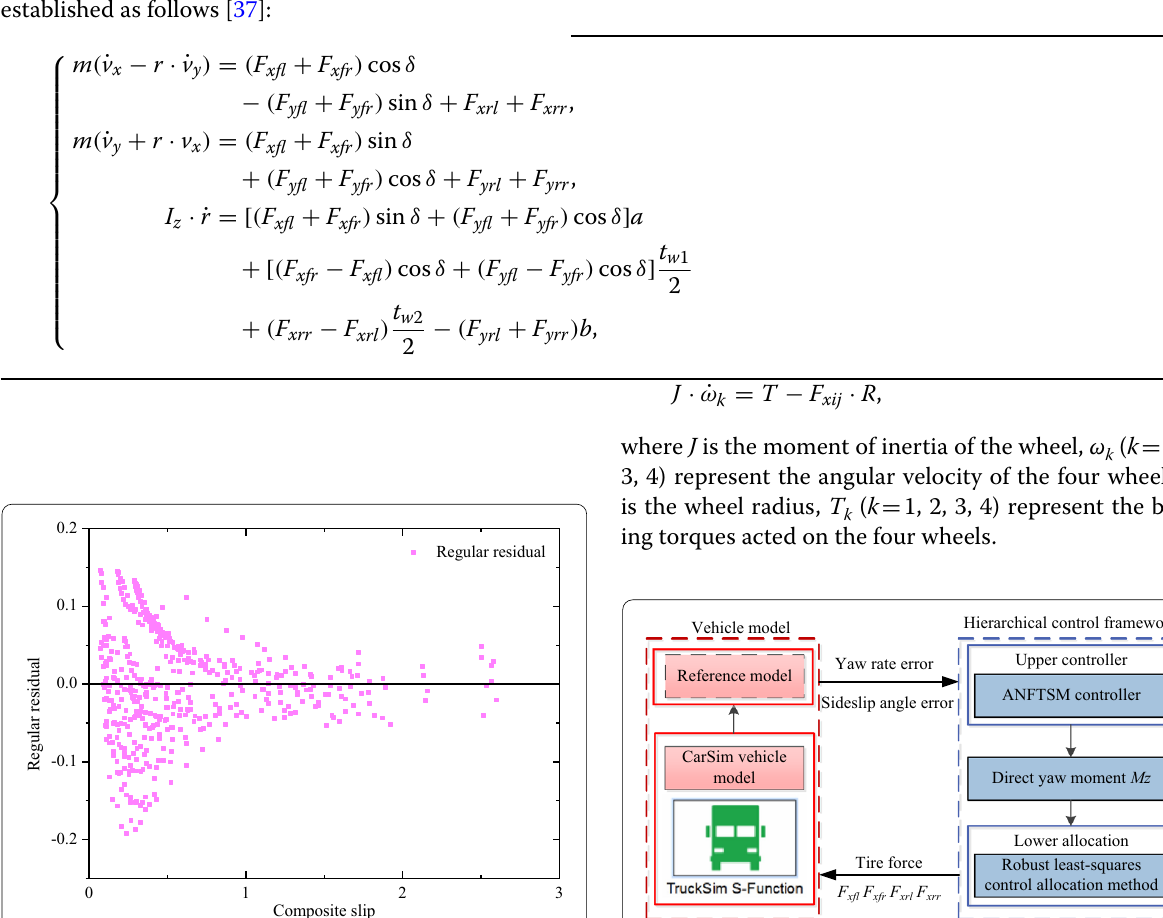
Robust least-squares control allocation method